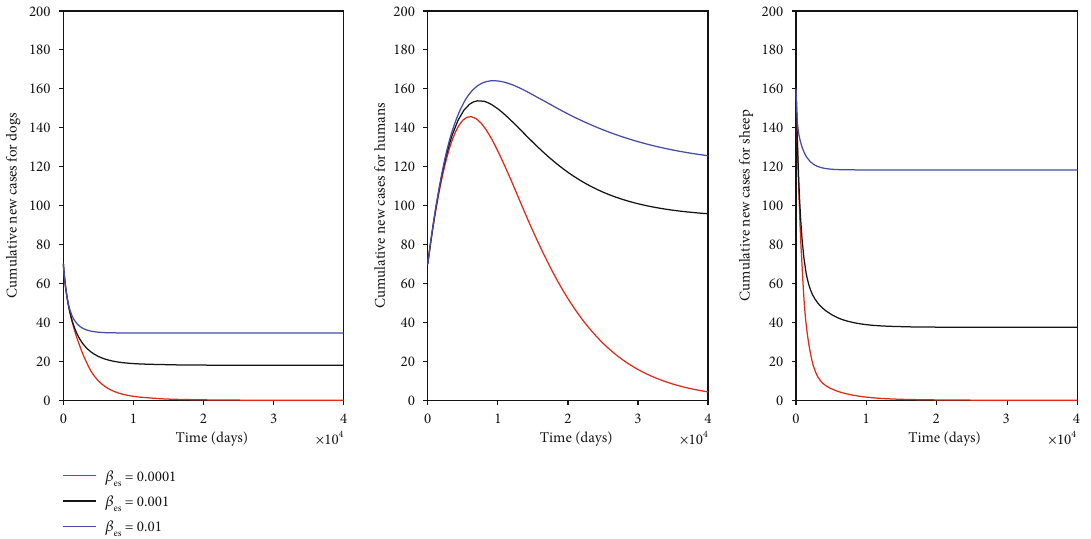
Figure 5: The numerical simulations displaying e ff ects of controlling strategies on the cumulative number of infectious dog, human, and sheep populations, using parameter values in Table 3, with varying values of β